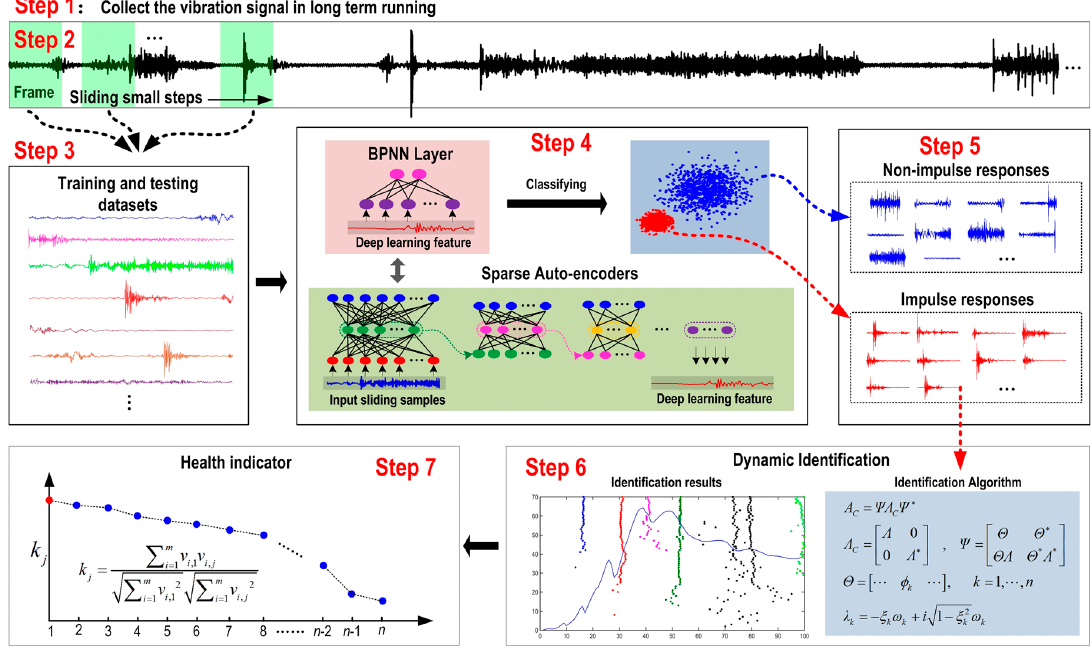
Figure 5. Framework of the early fault detection method based on deep learning and dynamics identification from [101] , Copyright 2019, IEEE.